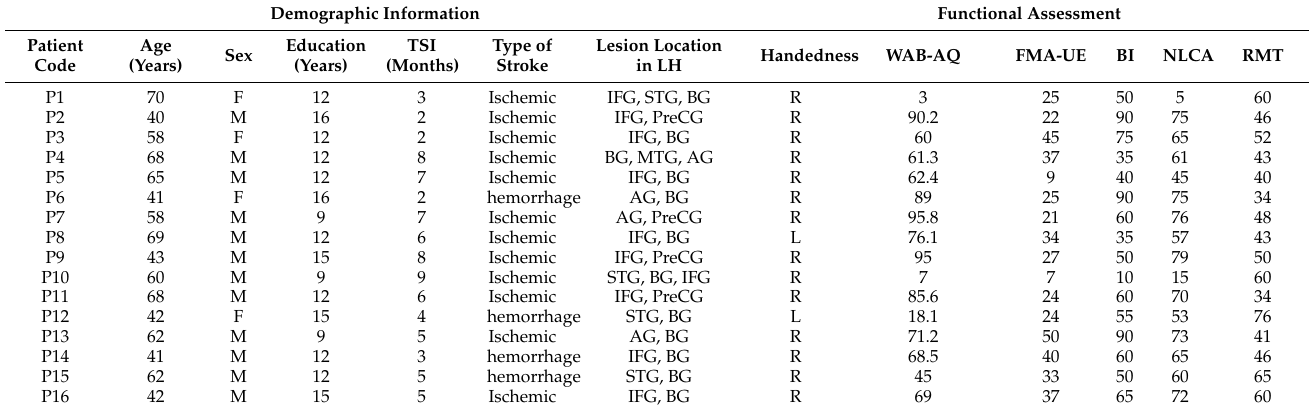
Table 1. Demographic and clinical information of the